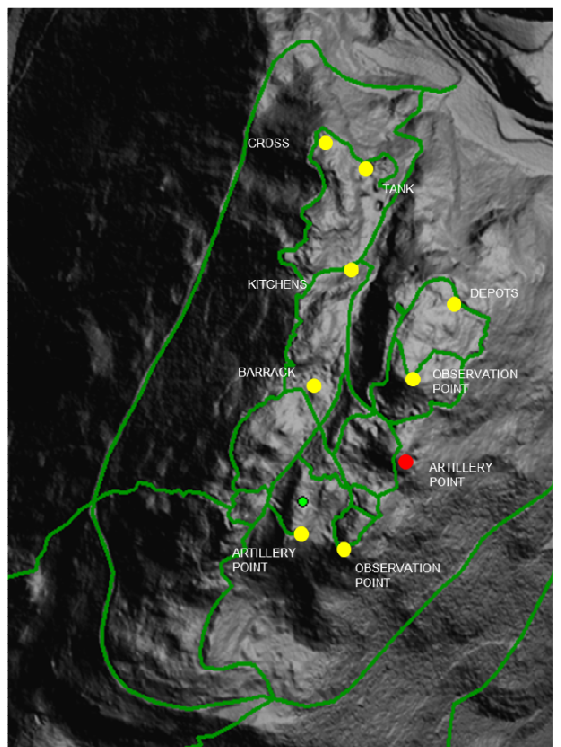
Figure 10. The location of some strategic elements of the Nagià Grom military site